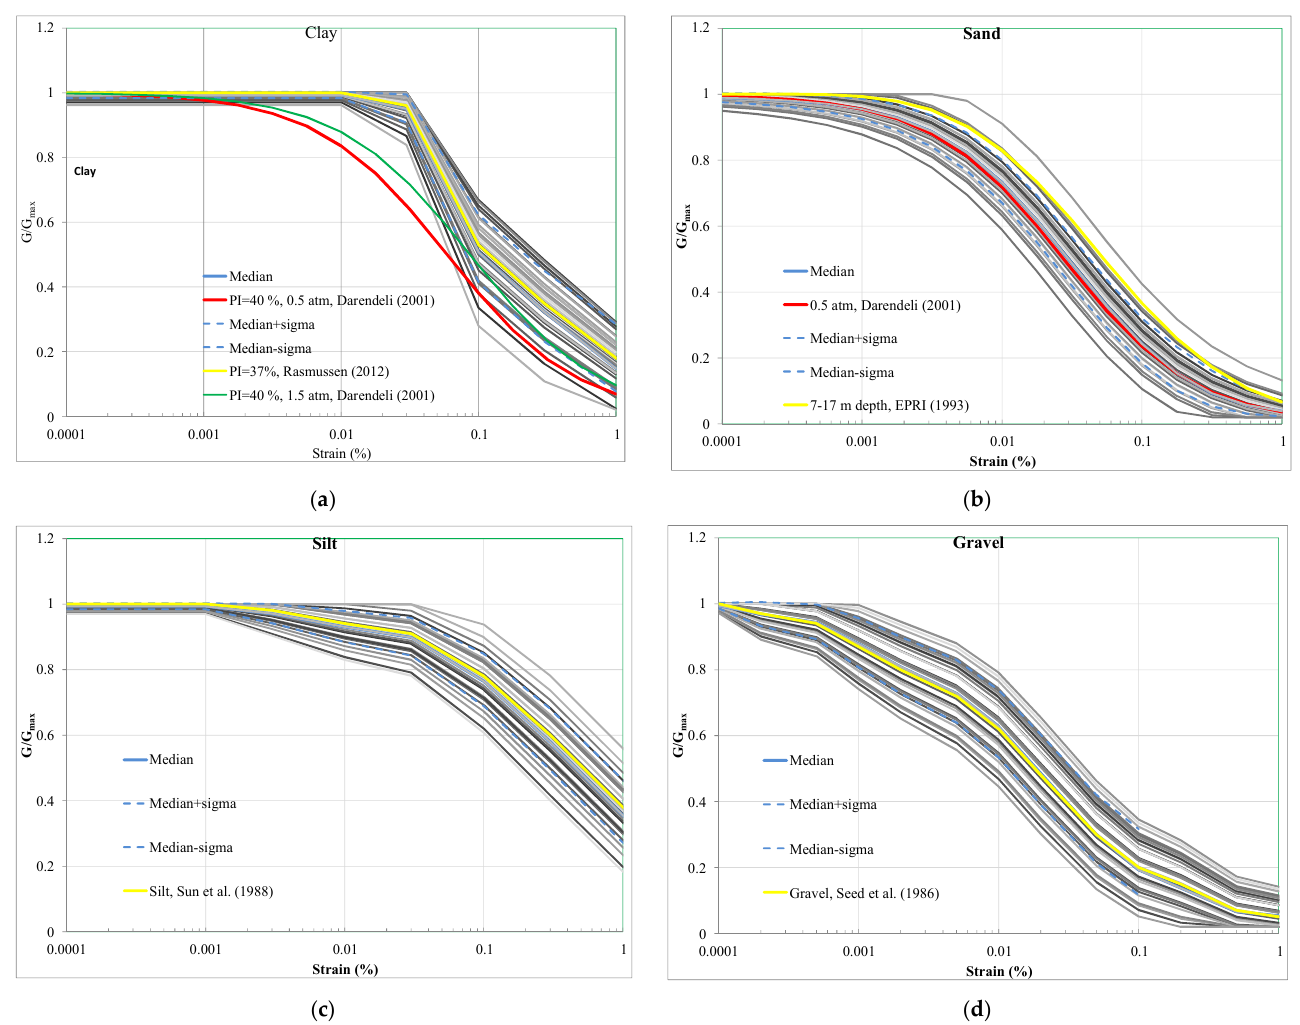
Figure 7. Randomized G/Gmax and strain (%) curves for ( a ) clay, ( b ) sand, ( c ) silt, and ( d ) gravel. The curves in gray in the above figures are generated from the randomization.